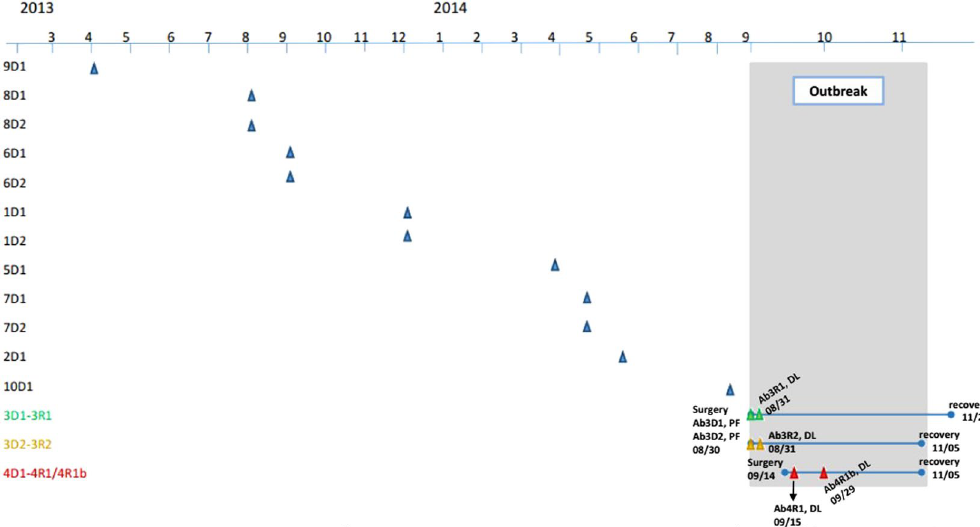
Figure 4. Patient trace. Timeline of first positive cultures (refering to the first time that A . baumannii was identified in the liquid samples) of the outbreak isolates. The blue triangles represent A . baumannii isolates gained from preservation fluid of donors. The green (3D1-3R1), yellow (3D2-3R2), red (4R1) triangles represent the first positive cultures of outbreak A . baumannii isolates. Dates are given as month/date. Culture of 3D1’s kidney preservation fluid sample collected on August 30th grew A . baumannii , and culture of draining liquid collected after the transplantation (August 31st) for 3R1 grew A . baumannii as well. The same situation occurred in 3D2 and